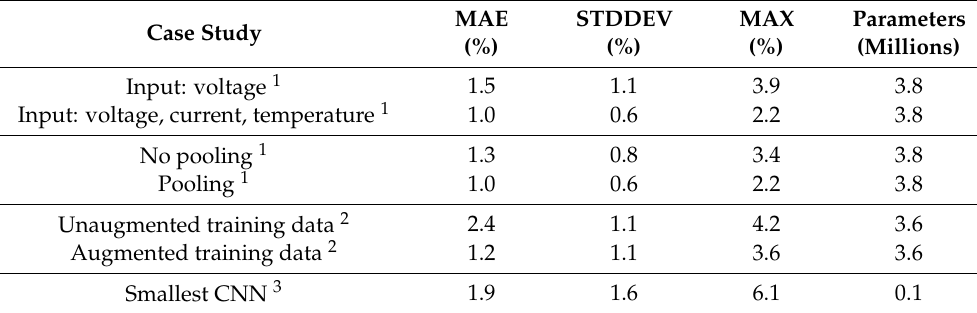
Table 3. SOH estimation accuracy of CNN for different test